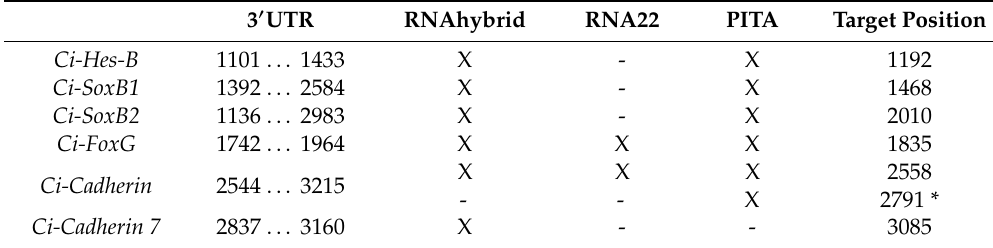
Table 1. List of the results obtained from in silico analysis of miR-9 putative targets in C. intestinalis . RNAhybrid, RNA22, and PITA programs. A target was considered valid when found inside the 3 (cid:48) UTR region. 3 (cid:48) UTR RNAhybrid RNA22 PITA Target Position Ci-Hes-B 1101 ... 1433 X - X 1192 Ci-SoxB1 1392 ... 2584 X - X 1468 Ci-SoxB2 1136 ... 2983 X - X 2010 Ci-FoxG 1742 ... 1964 X X X 1835 X X X 2558 Ci-Cadherin 2544 ... 3215 - - X 2791 * Ci-Cadherin 7 2837 ... 3160 X - - 3085 * target site predicted only by